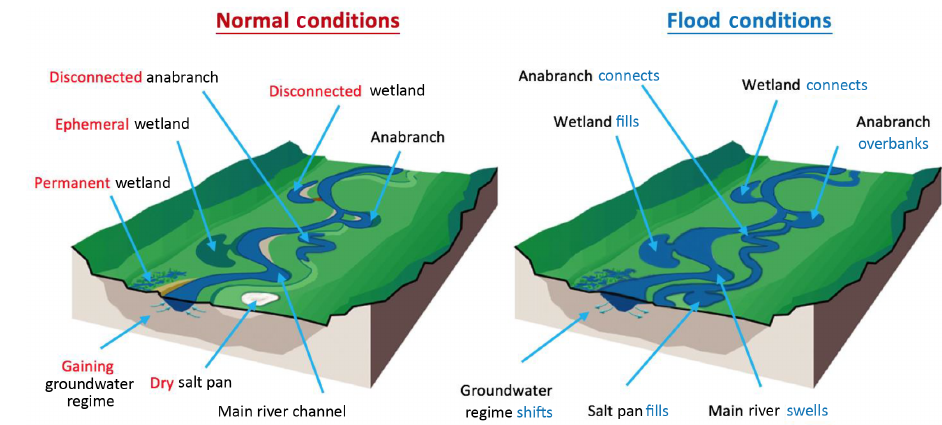
Figure 2. Processes affecting saline accessions during normal and flood conditions.